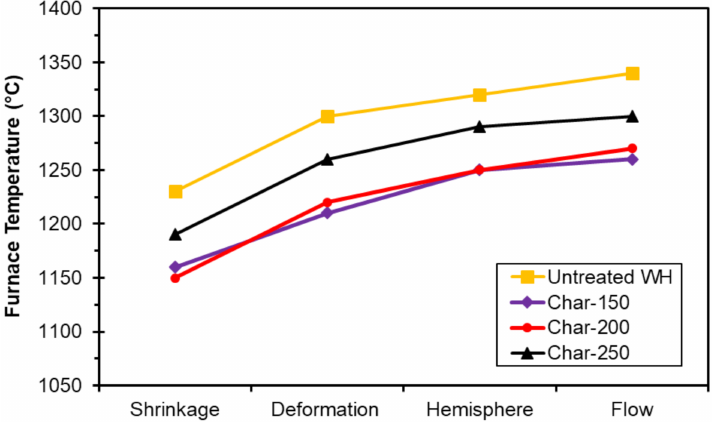
Figure 3. Ash fusion transition temperatures for untreated water hyacinth (WH) and water hyacinth hydrochars). Char-150 = WH hydrochar produced at 150 ◦ C. Char-200 = WH hydrochar produced at 200 ◦ C. Char-250 = WH hydrochar produced at 250 ◦